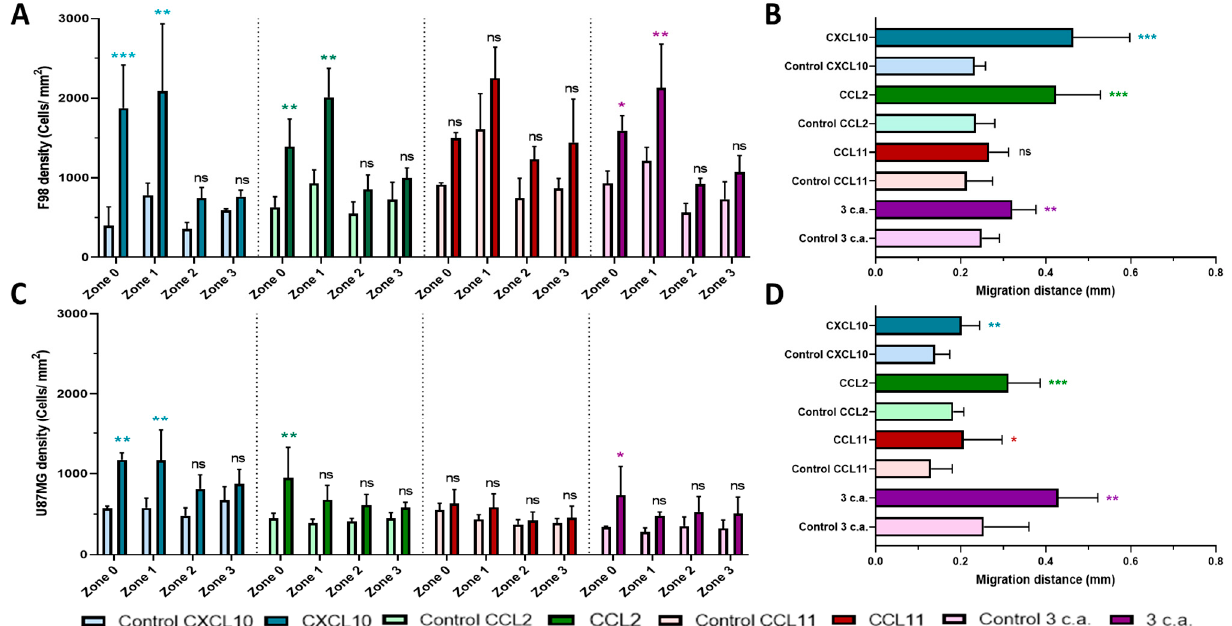
Figure 2. Summary of the Agarose drop assay for chemokines CXCL10, CCL2 and CCL11 individually and combination (3 c.a.). ( A ) Chemotactic potency of different chemokine and ( B ) average migration distance inside of the agarose drop for the F98 tumor cells. Same experiments in ( C , D ) for the U87MG cell line. Data obtained from images were taken 16 hours after initiating the test, n = 3 for each condition. *, p < 0.05, **, p < 0.01, ***, p < 0.001, ns, not significant. The asterisk is added above the value that is compared to the control on the left (A and C) or it is added next to the value that is compared to the control below (B and D).